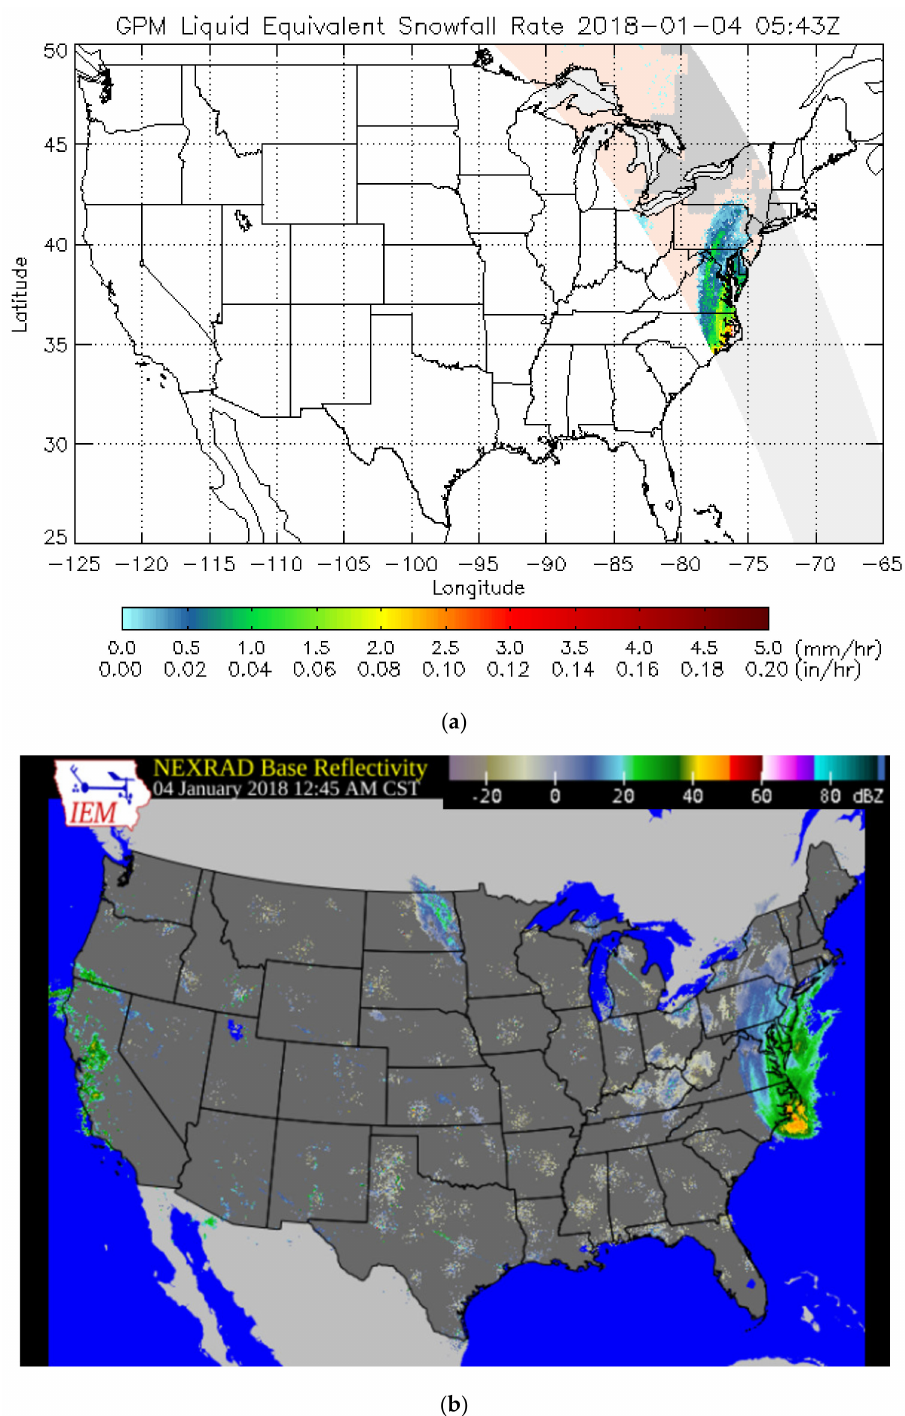
Figure 5. ( a ) Retrieved GMI-based Liquid Water Snowfall Rate in mm hr − 1 on 4 January 2018 5:43 Zulu time and ( b ) near coincident NEXRAD base reflectivity in